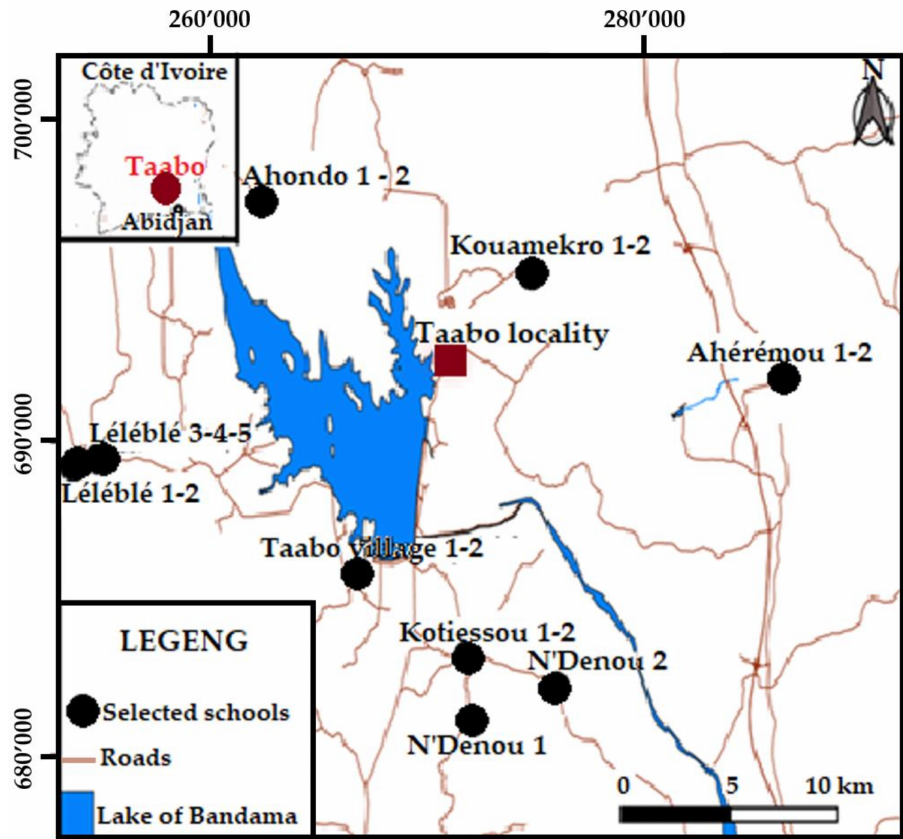
Figure 1. Study area and location of schools in Taabo health and demographic surveillance system in the south-central part of C ô te d’Ivoire.